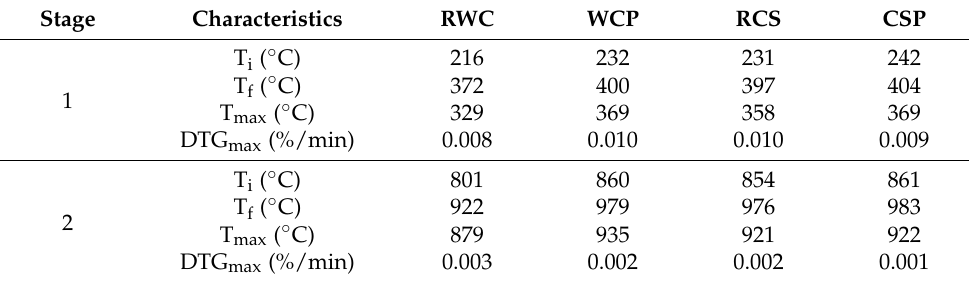
Table 3. Characteristics parameters of RWC, WCP, RCS, and CSP. Stage Characteristics RWC WCP RCS CSP